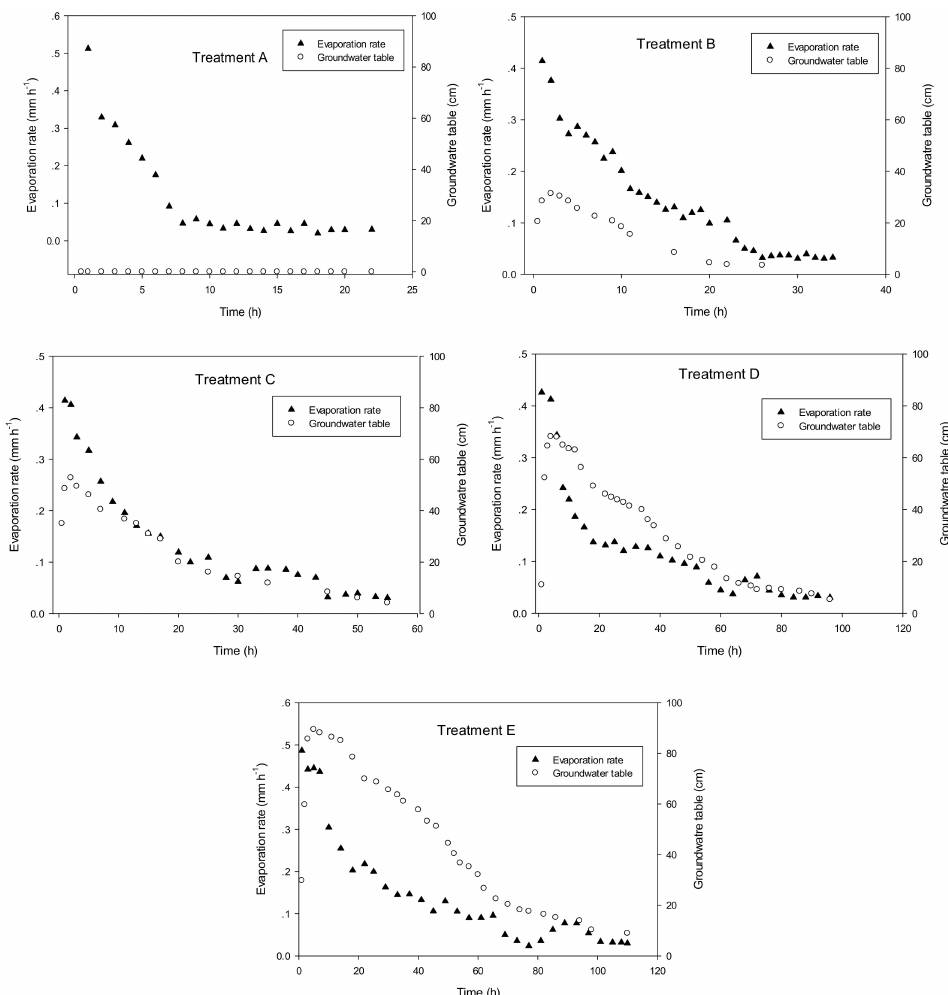
Figure 5. Hourly variation in the evaporation rate and groundwater table after flooding in five treatments (the right axis shows the changes of groundwater